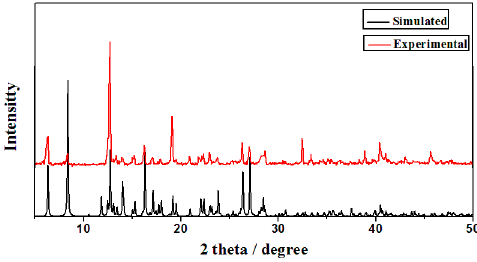
Figure 4. The powder XRD patterns and the simulated one from the single-crystal diffraction data for the complex 1 .